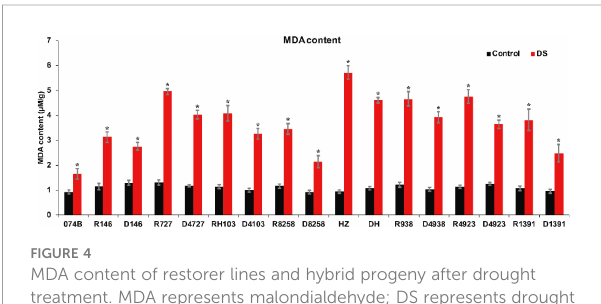
FIGURE 4 MDA content of restorer lines and hybrid progeny after drought treatment. MDA represents malondialdehyde; DS represents drought stress treatment. Error bars denote standard deviations ( n = 3); “ * ” stands for signi fi cance between drought stress and control condition in the same cultivar (p ≤ 0.05).